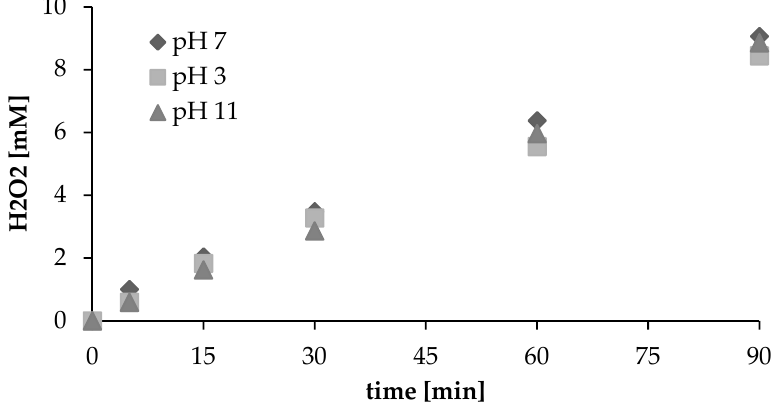
Figure 3. Influence of pH values and duration of ultrasonic irradiation (at a constant intensity of 4.3 W/cm 2 ) on the formation of H 2 O 2